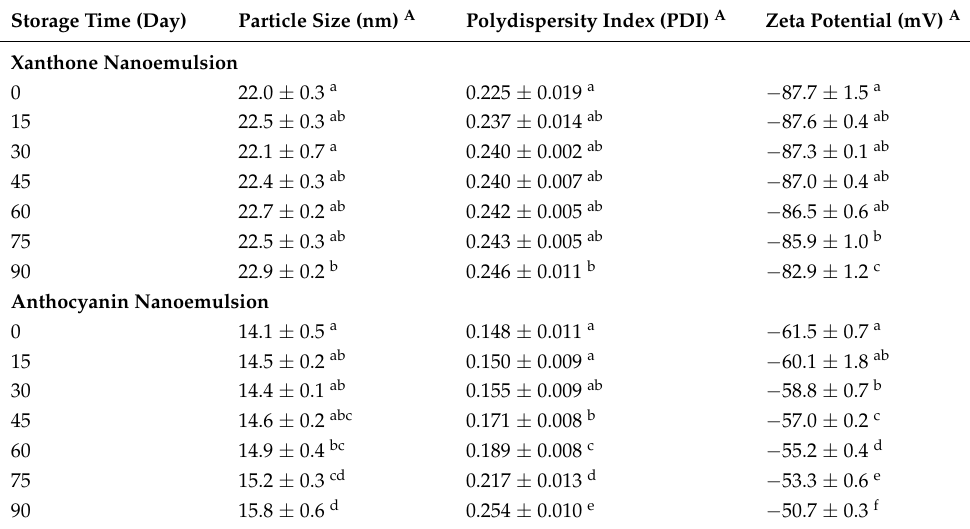
Table 4. Particle size, polydispersity index and zeta-potential of xanthone and anthocyanin nanoemul- sion during storage at 4 ◦ C for 90